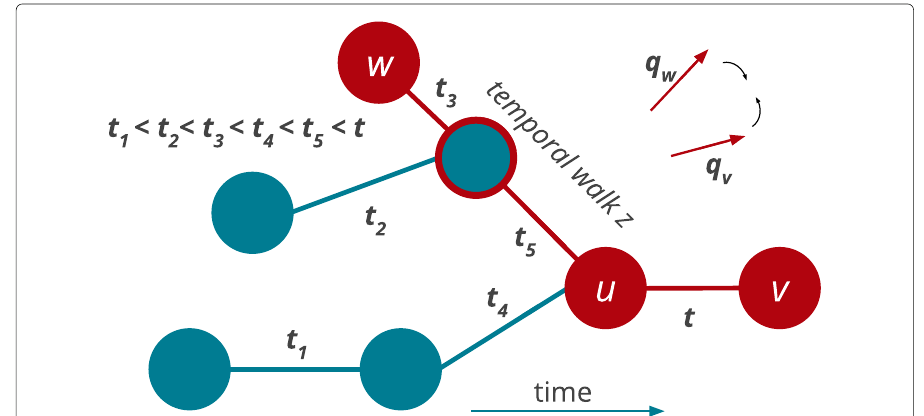
Fig. 3 StreamWalk: learning embeddings based on random walks to the past in temporal